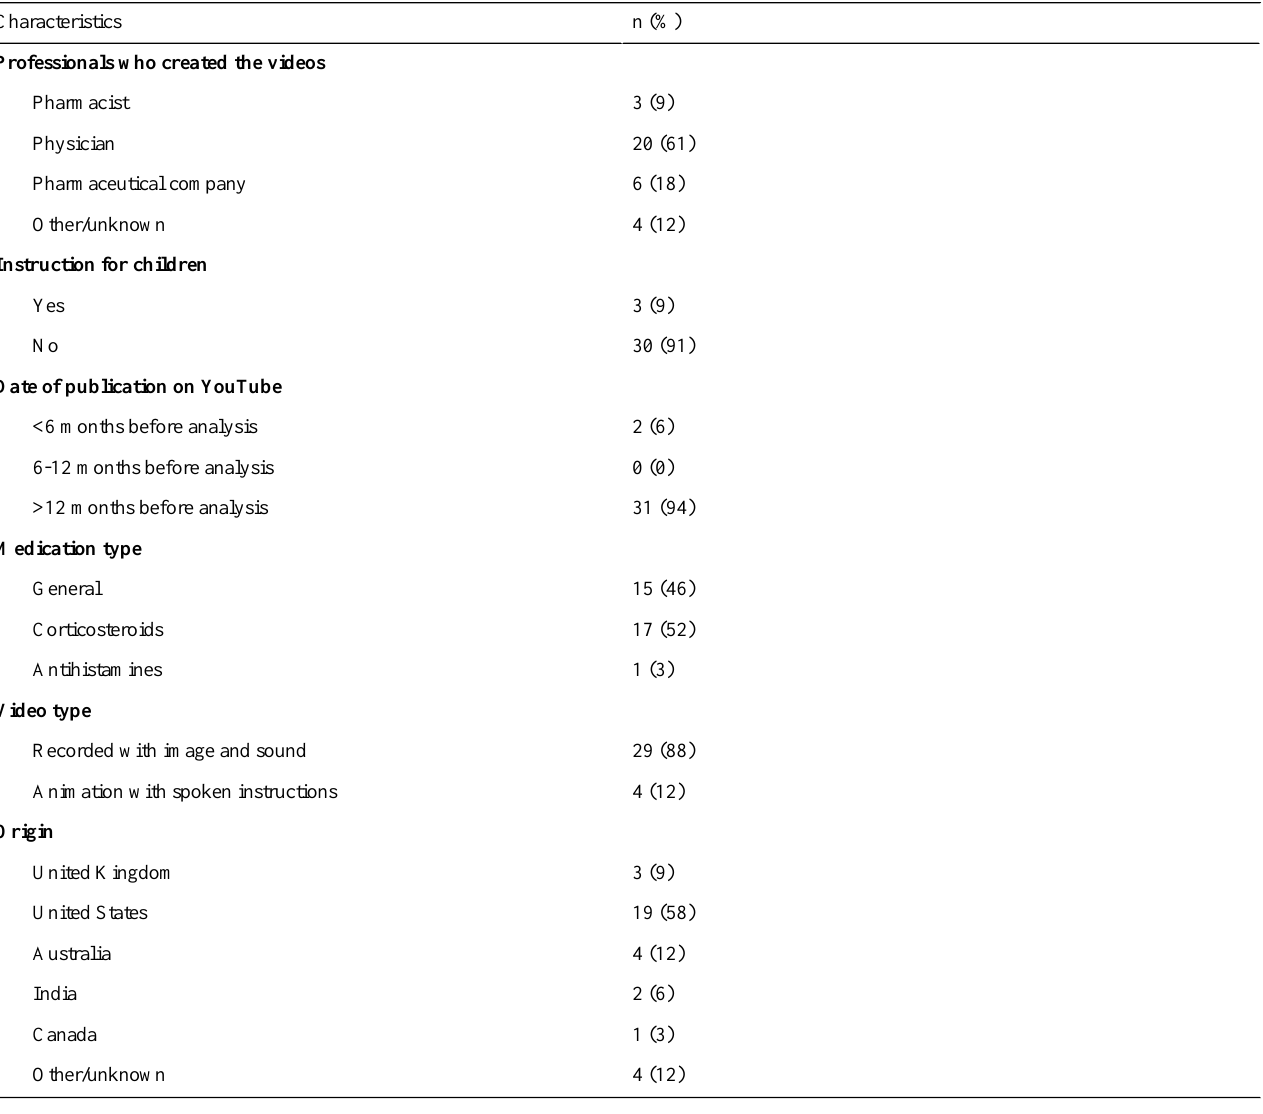
Table 1. Characteristics of the analyzed YouTube videos